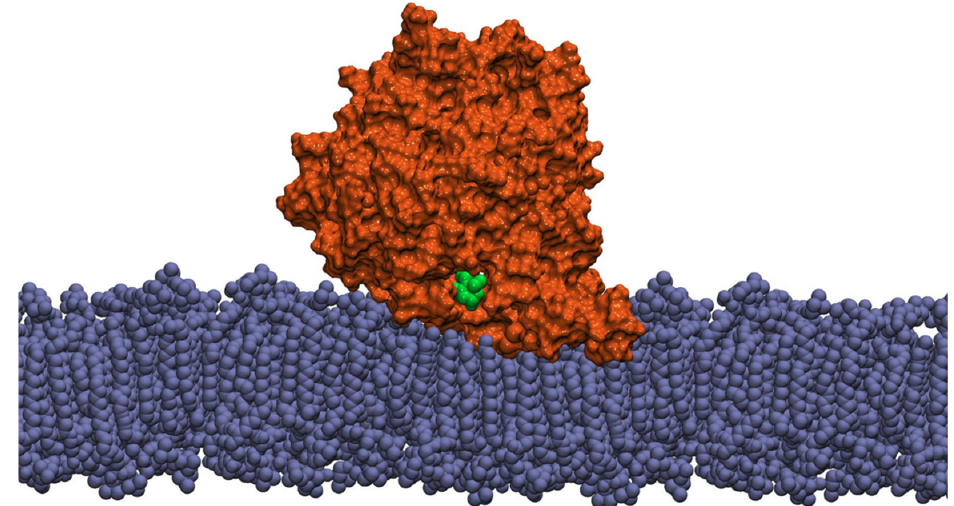
Figure 4. Representation of the CCD4b model (orange), including a β -carotene ligand molecule (green), interacting with a biological membrane model (blue), through its α 1 and α 3 domains.